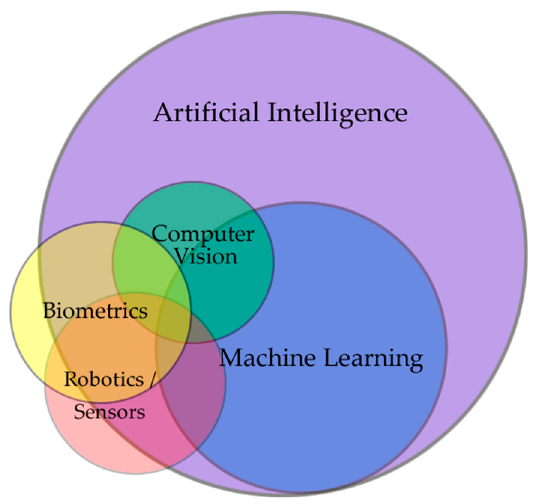
Figure 5. Venn diagram showing the relationship between artificial intelligence and other integrated technologies. Those that are outside the main category represent techniques that may function as stand-alone and do not necessarily enter within the artificial intelligence group in all cases.